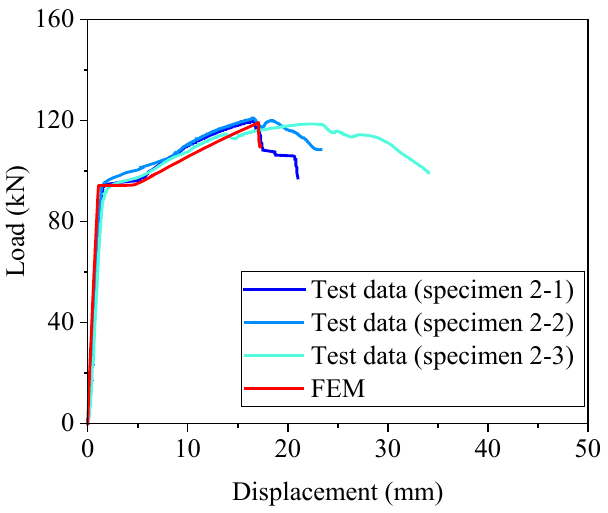
Figure 30. Verification of the finite element modeling.